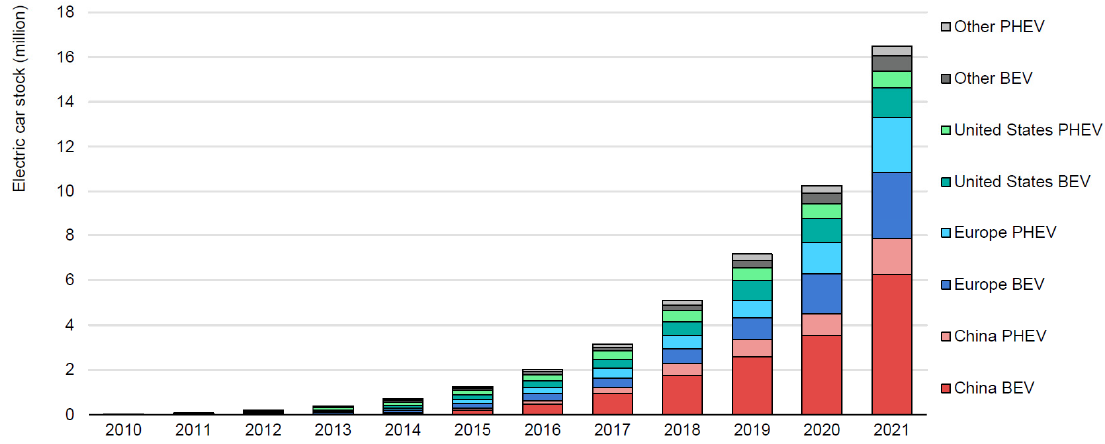
Figure 1. Global electric vehicles fleet from 2010 to 2021.